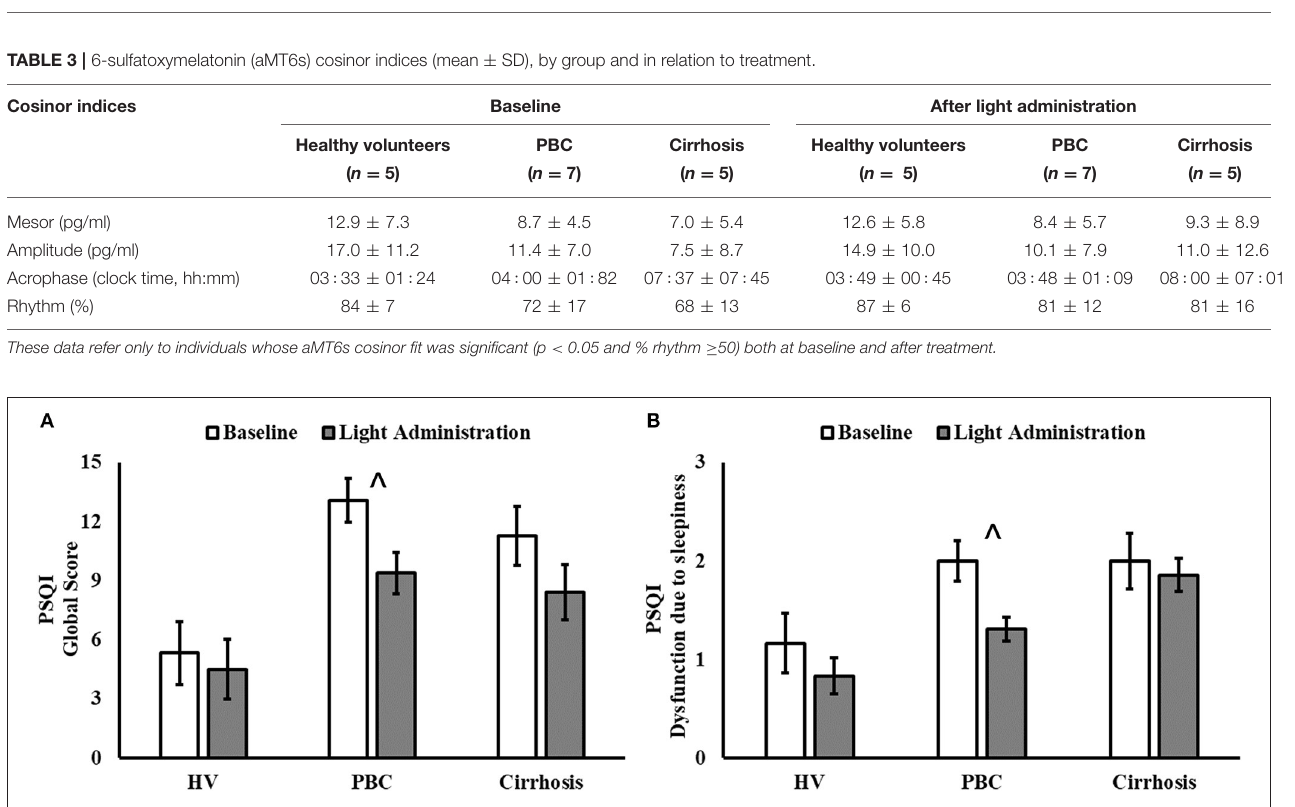
absolute values for wake after sleep onset decreased during light administration in patients with cirrhosis ( Table 2 ), and the difference between baseline and treatment was significant ( p < 0.05) when comparisons were confined to this patient group. Analyses by day and by week confirmed the averaged data analyses. Finally, 5 healthy volunteers, 7 patients with PBC and 5 patients with cirrhosis had significant cosinor fits for their aMT6s rhythms both at baseline and after light treatment. Robustness of aMT6s rhythmicity (i.e., strength of the cosinor fit expressed as a percentage rhythm) significantly increased after light administration ( Figure 3 ) but post-hoc comparisons